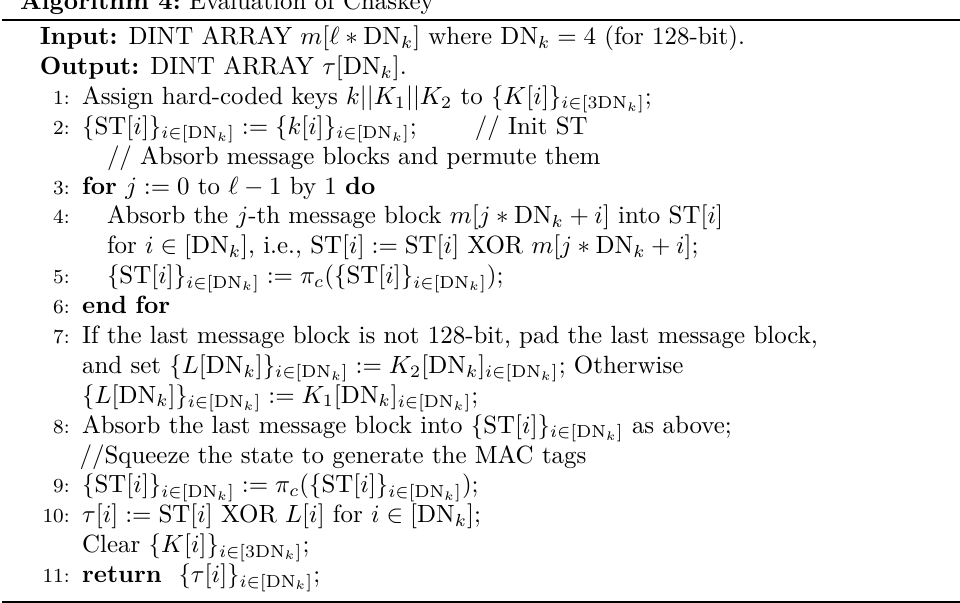
Algorithm 4: Evaluation of Chaskey